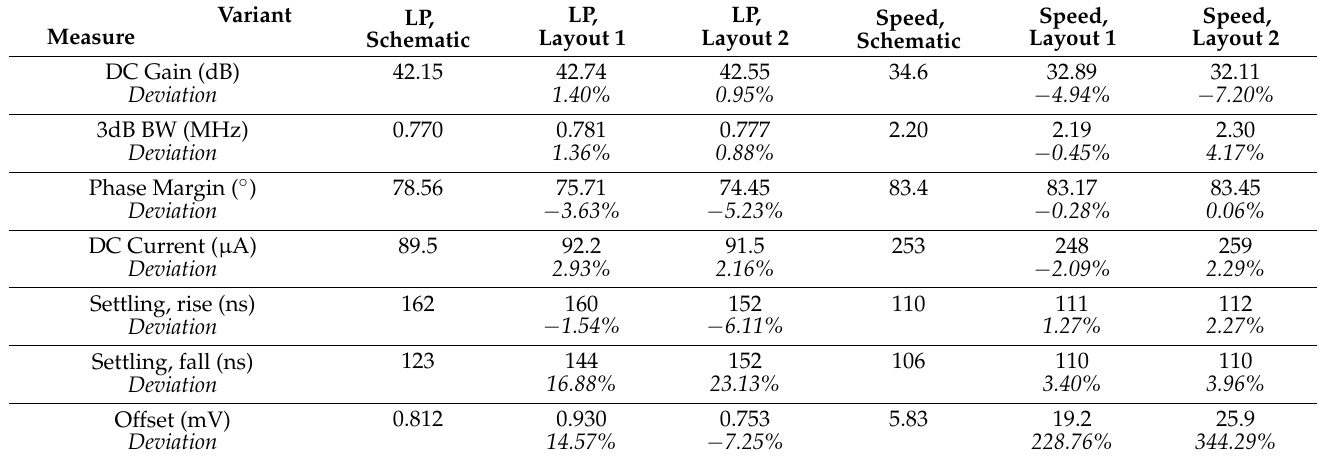
Table 1. Comparison of schematic-level and post-layout simulations of the amplifier variants.